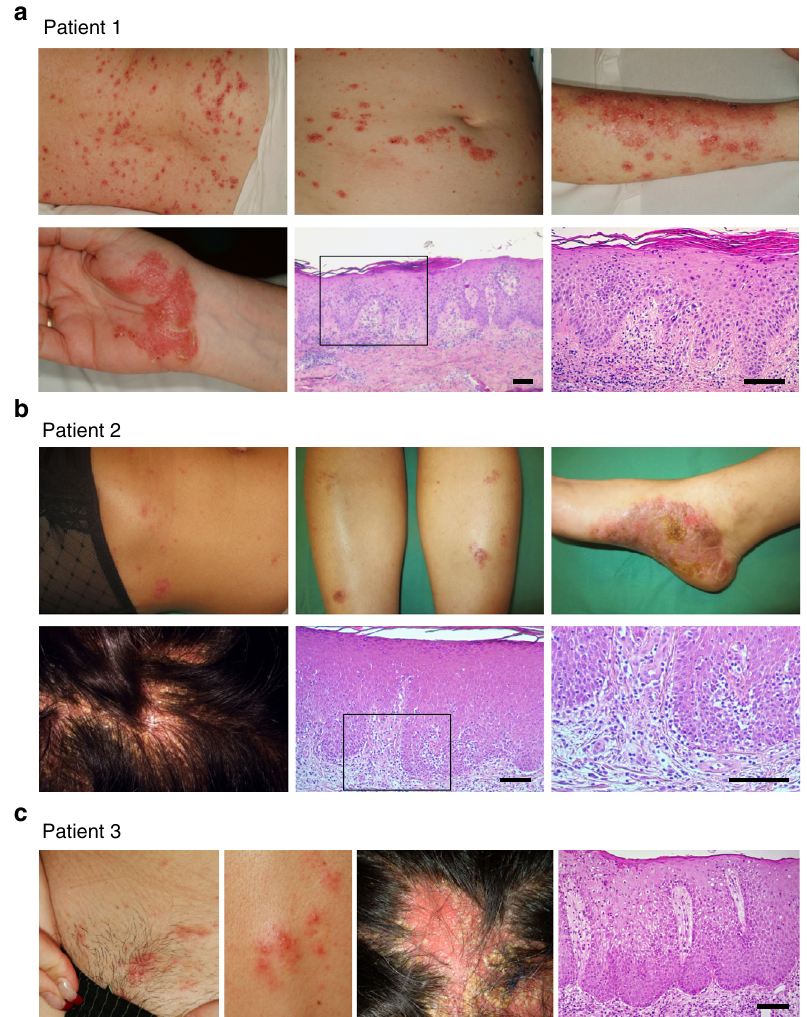
Fig. 1 Clinical and histological presentation of paradoxical psoriasis. a – c Photographs of cutaneous lesions and corresponding histopathology of three individual patients presenting paradoxical psoriasis. a Patient 1 with small erythemato-squamous plaques disseminated over the entire body resembling guttate psoriasis and palmoplantar psoriasis-like lesions. Histology with a classical psoriasis pattern with acanthosis, papillomatosis, parakeratosis, and loss of the granular layer, but with spongiosis. b Patient 2 with partially crusted, eczematiform lesions on her legs and trunk, palmoplantar psoriasis-like lesions, and severe scalp involvement. Histology with acanthosis, papillomatosis, also in addition to spongiosis and minimal interface dermatitis. c Patient 3 with small erythematous plaques and pustules. Noncicatricial alopecia on the site of scalp involvement. Histology with acanthosis, papillomatosis, and spongiosis. Clinical signs and histopathology of the patients shown are representative of the patient population in this